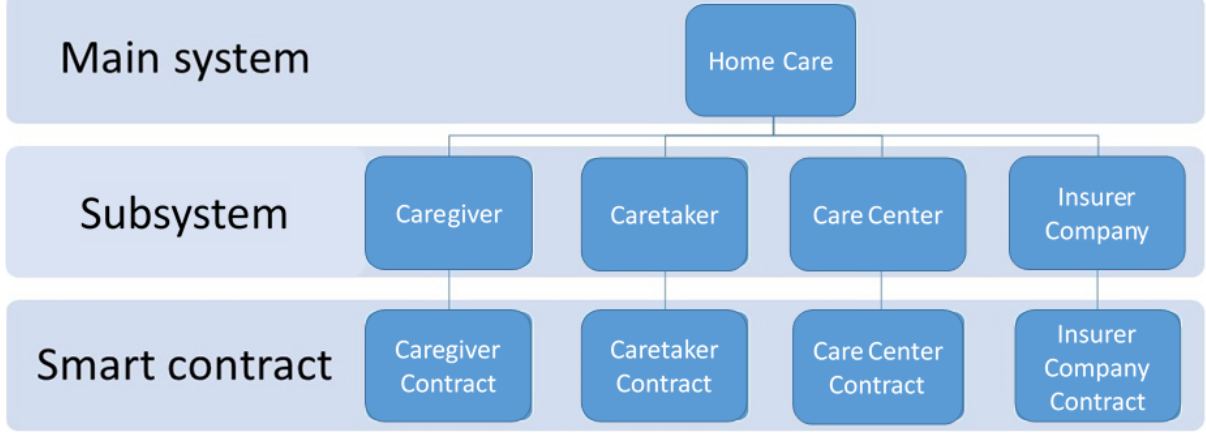
Figure 6. Architecture of the home care service